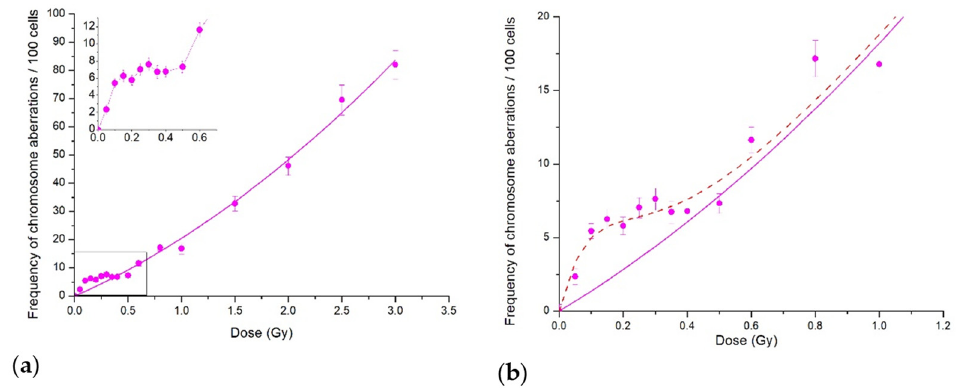
Figure 1. Cytogenetic effects of protons at the Bragg curve plateau for CHO-K1 cells: ( a ) CA in the whole dose range studied; the inset shows the low-dose region; ( b ) CA for doses below 1 Gy. Each point represents the mean ± SEM. Solid lines are LQ model approximations; dash line shows our fit to the data of the IR model.